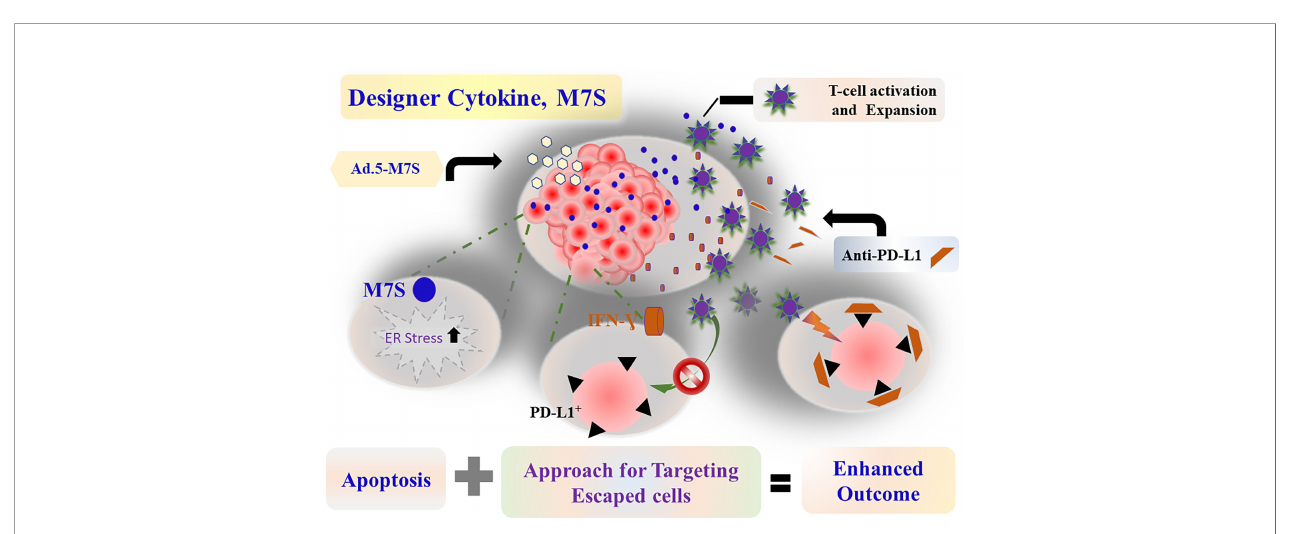
FIGURE 9 | Schematic presentation of MDA-7 (IL-24) action in combination with